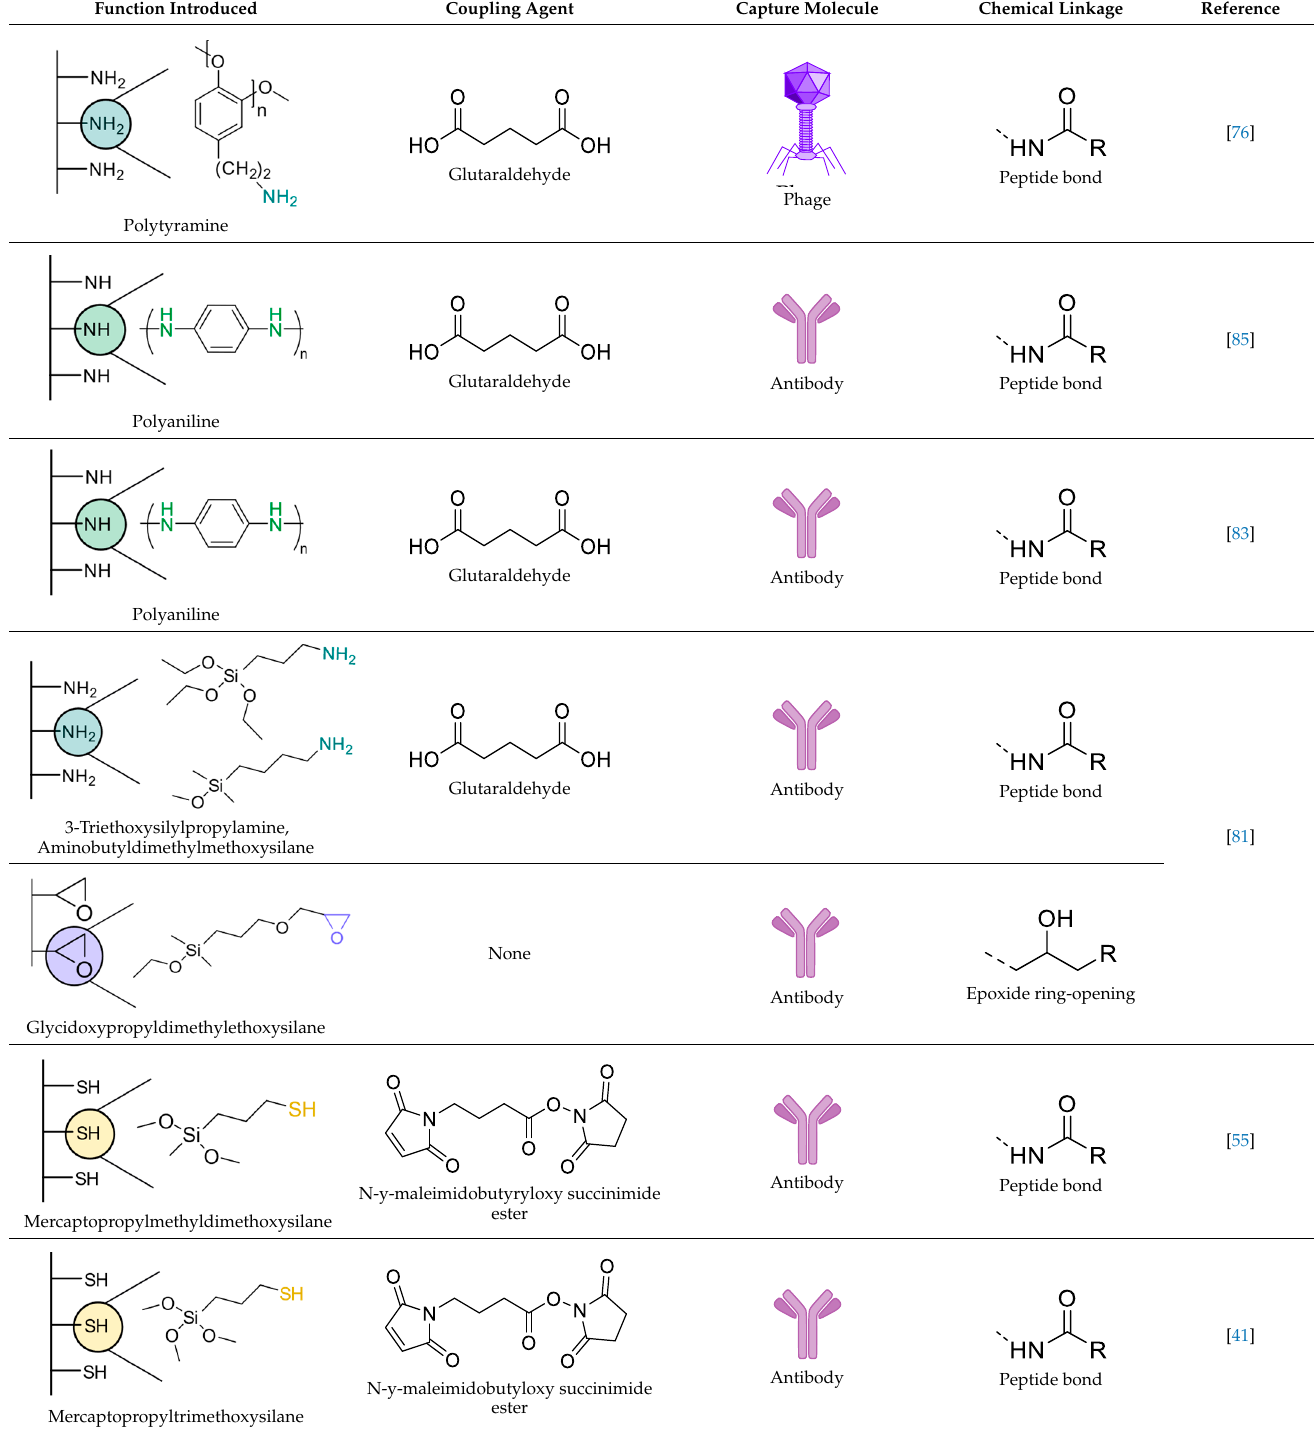
Table 2. Methods reported for the covalent conjugation of capture biomolecules on insulating lay- ers. R: Capture molecule.